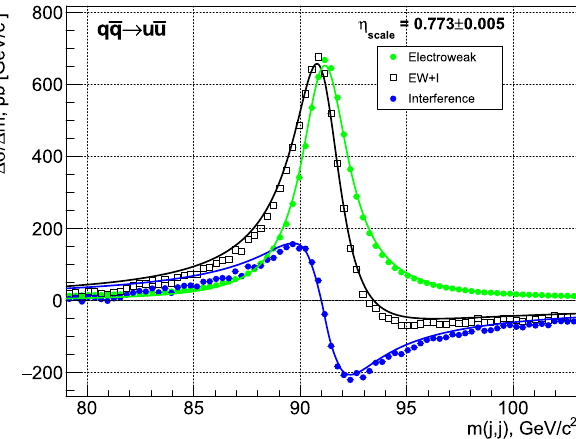
Fig. 2 The process qq → uu . Left shows the pure electroweak (pale/green), pure QCD (dark/red) and total (black) cross-sections. Right has the same electroweak component, but the hollow black points